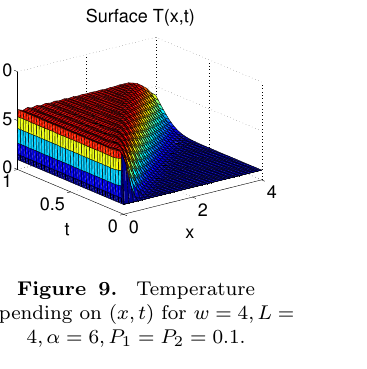
Figure 9. Temperature depending on ( x,t ) for w = 4 ,L = 4 ,α = 6 ,P 1 = P 2 = 0 . 1.